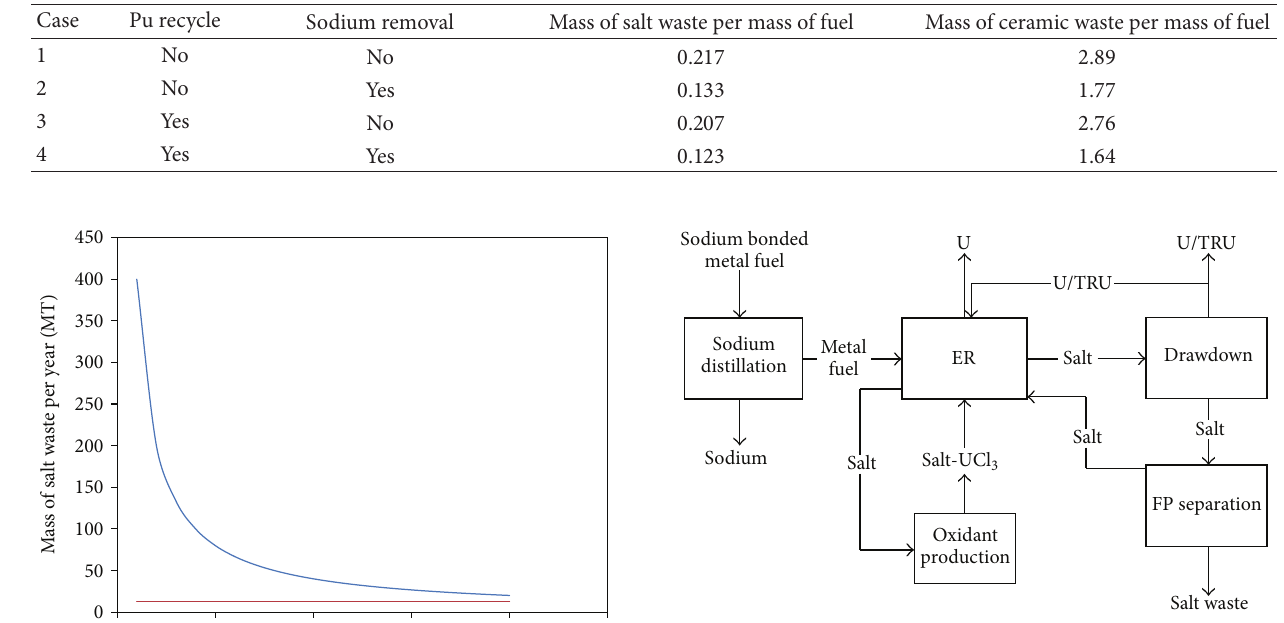
Table 3: Salt waste calculations based on nominal composition and total mass limit.